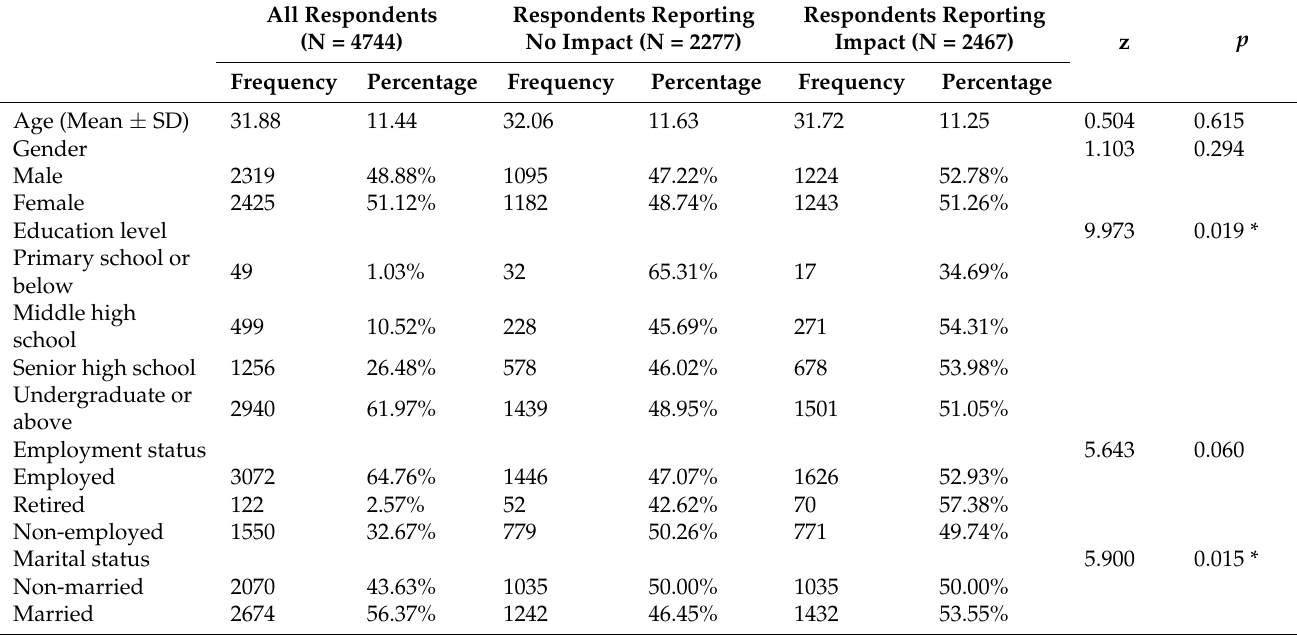
Table 1. Demographic characteristics and health services utilization of the study